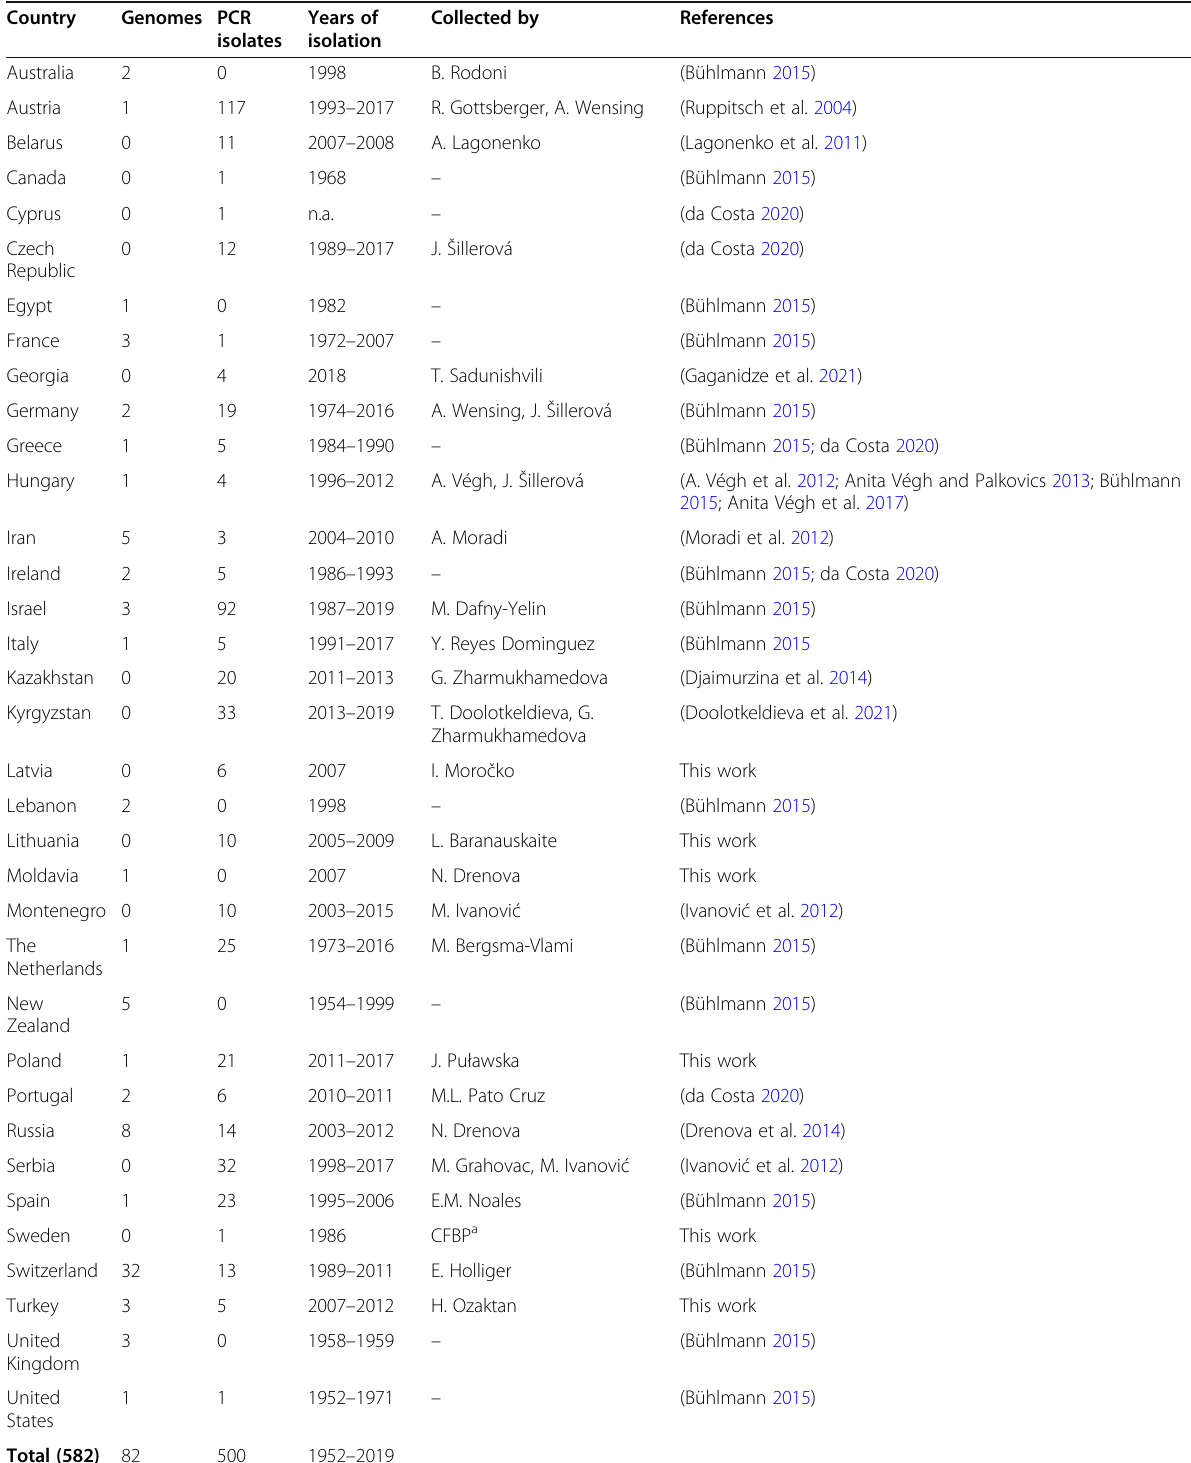
Table 1 Origin, number and year of isolation of E. amylovora isolates analyzed in this project. The list consists of both isolates received as inactivated cells and tested by PCR alone, including some literature strains (da Costa 2020), as well as fully sequenced strains whose genome data were already available (Bühlmann